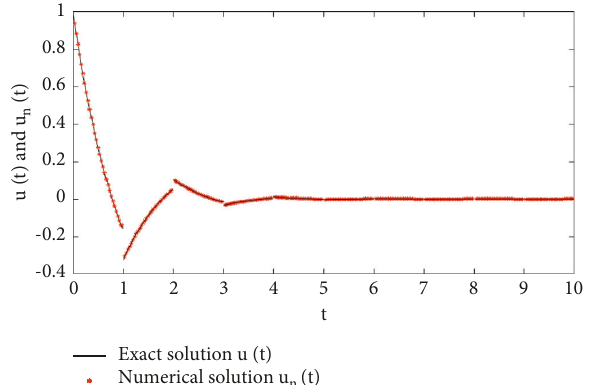
Figure 2: Comparisons of the results of Example 2 ( n � 30 ) .